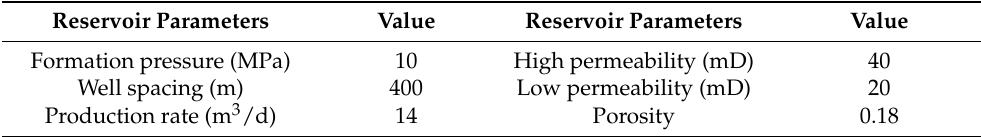
Figure 7. Heterogeneous reservoir models where a five-spot well pattern is implemented: ( a ) hori- zontal heterogeneous model; ( b ) vertical heterogeneous model. Table 3. Parameters of heterogeneous reservoir model.